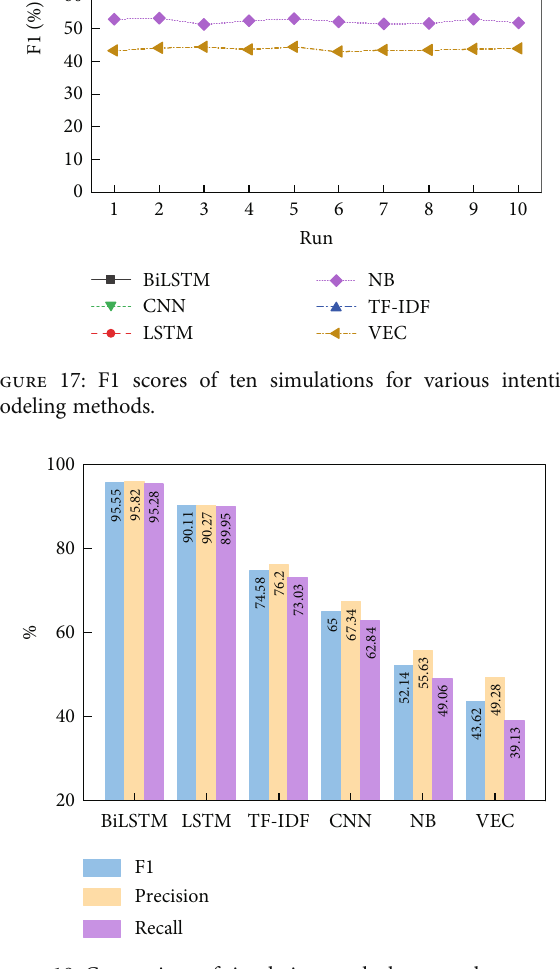
Figure 18: Comparison of simulation results between the proposed method and other intention modeling